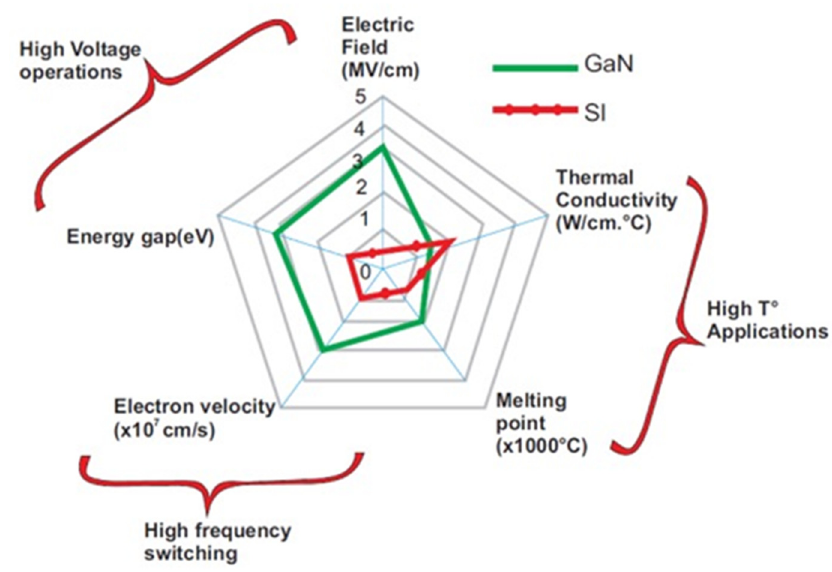
Figure 1. Differences in material properties between GaN and Si [2]. (Data from [2]).